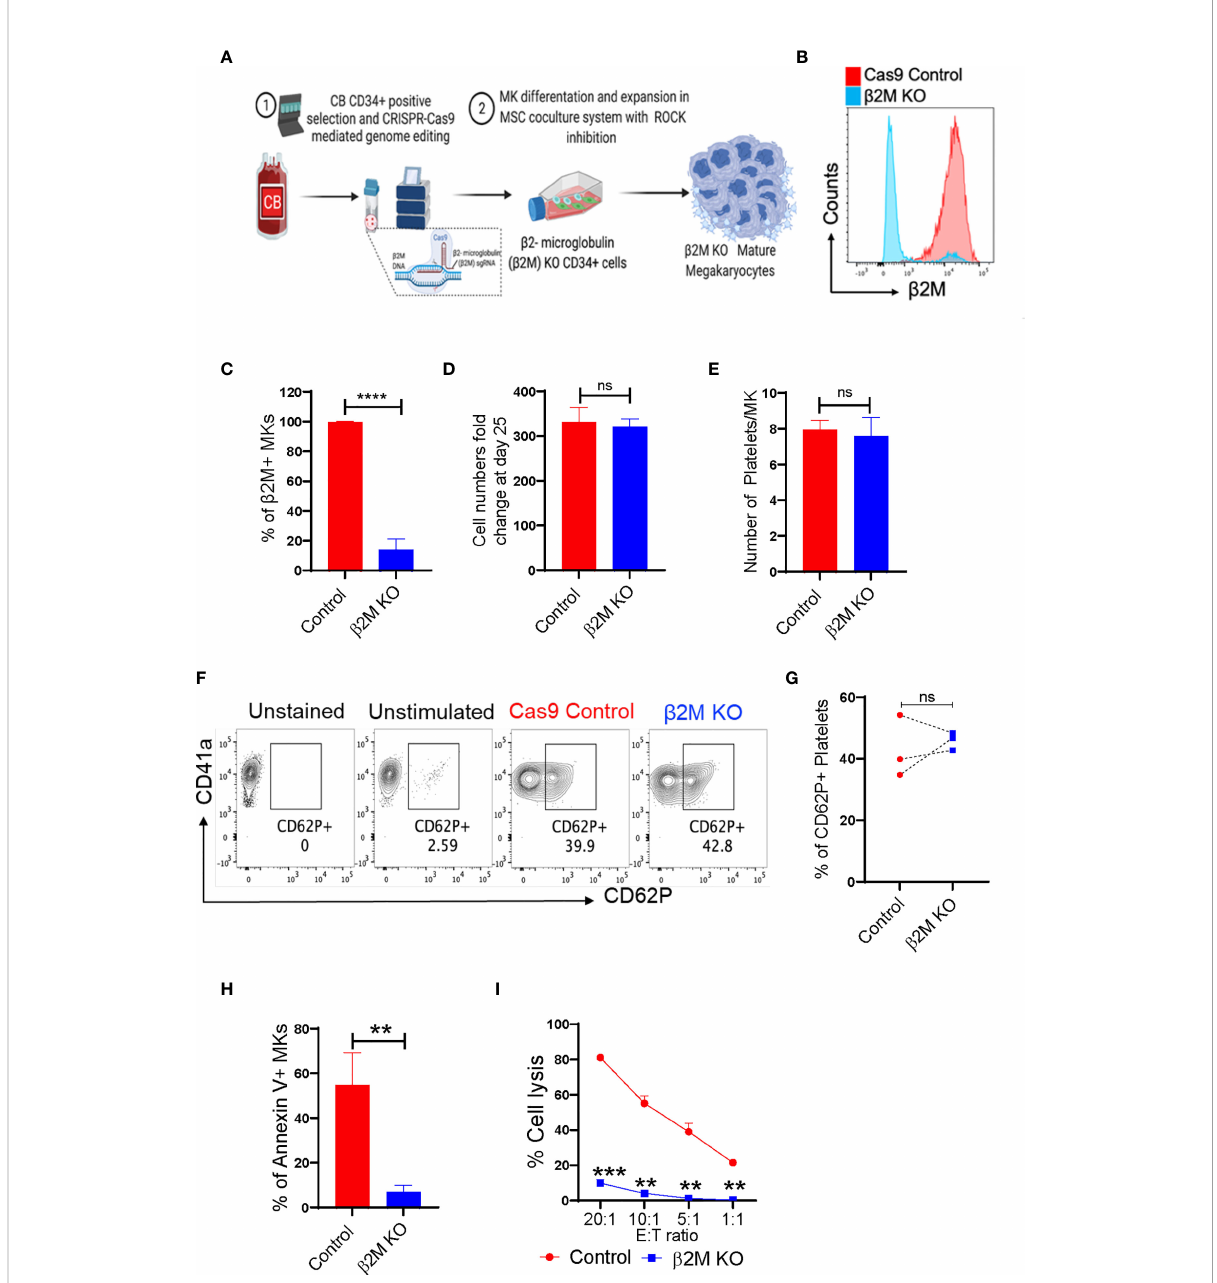
FIGURE 5 CRISPR-Cas9 engineered b 2M KO CB-HSCs/MKs have a similar maturation pro fi le and escape allogenic CD8+ T-cell-mediated killing. (A) Schematic of the generation of CRISPR-Cas9 edited b 2M KO MKs. (B) Histogram of b 2M expression in Cas9 control and CRISPR-Cas9 b 2M KO CD34+ cells at 72h after electroporation. (C) b 2M expression of the expanding and differentiating day 6 CB-derived CD34+ cells (n=3, ****p<0.0001). (D) Expansion potential comparison between Cas9 control and b 2M crRNA+Cas9 treated CB-derived cells (n=4). (E) Comparison of the number of platelets secreted per mature MK after 72h culture of day 22, KD045-primed control and b 2M KO MKs (n=3, p>0.15). (F) Flow cytometry contour plots of CD41a and CD62P expression in control and b 2M KO CB-MK-derived platelets. (G) Percentage of